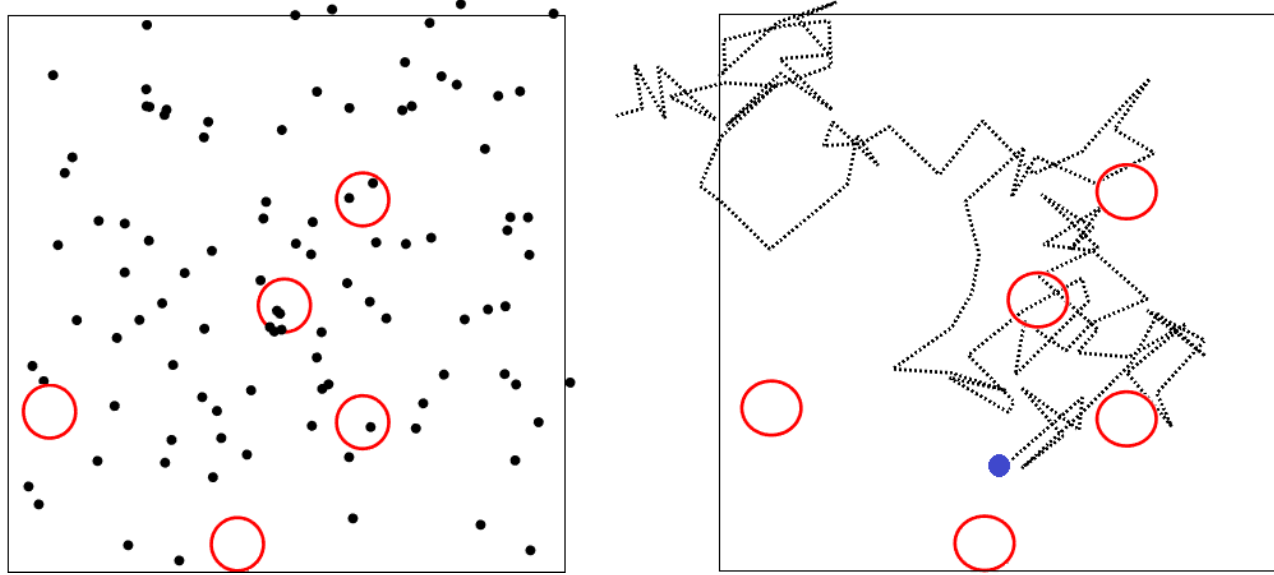
Figure 1. Illustration of the model. In the ( left ) panel, each black point represents an animal moving according to Equation (1) and the red circles represent the reception area of the receiver stations. The stations are located within the 1 × 1 enclosure. The homes of each animal are also within this space but are not included in this diagram. In each simulation, the value of the velocity and the value of the parameter attraction are fixed and are the same for all the animals. The ( right ) panel shows a trajectory for the case a = 0 with the same arrangement of receiver stations shown in the left panel. The blue circle represents the home of that